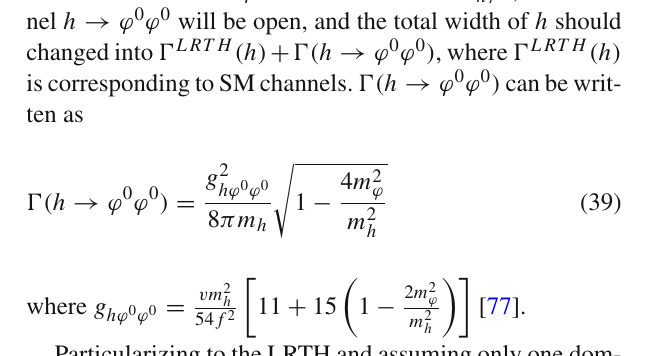
Fig. 3 The surviving samples within 1 σ , 2 σ , and 3 σ ranges of χ 2 points are respectively within the 1 σ , 2 σ , and 3 σ regions of χ 2